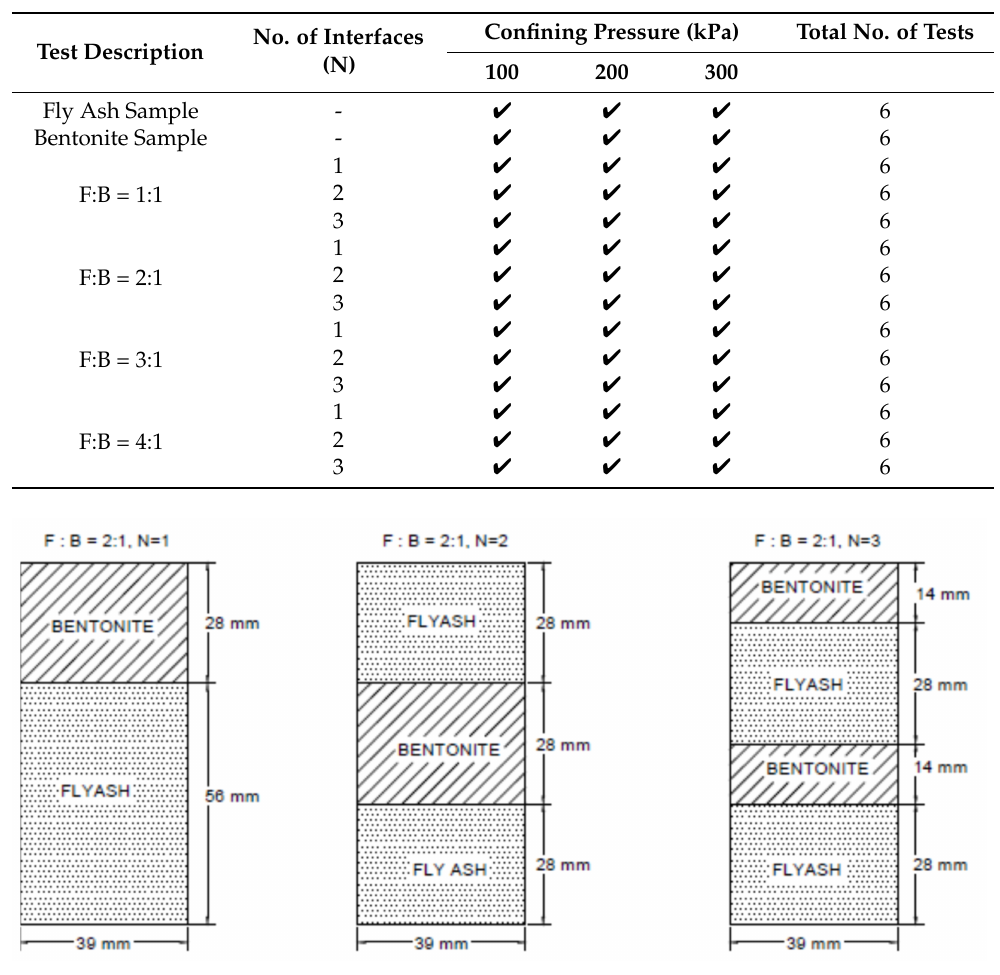
Figure 6. Diagrams representing the layered arrangement in samples for F:B =